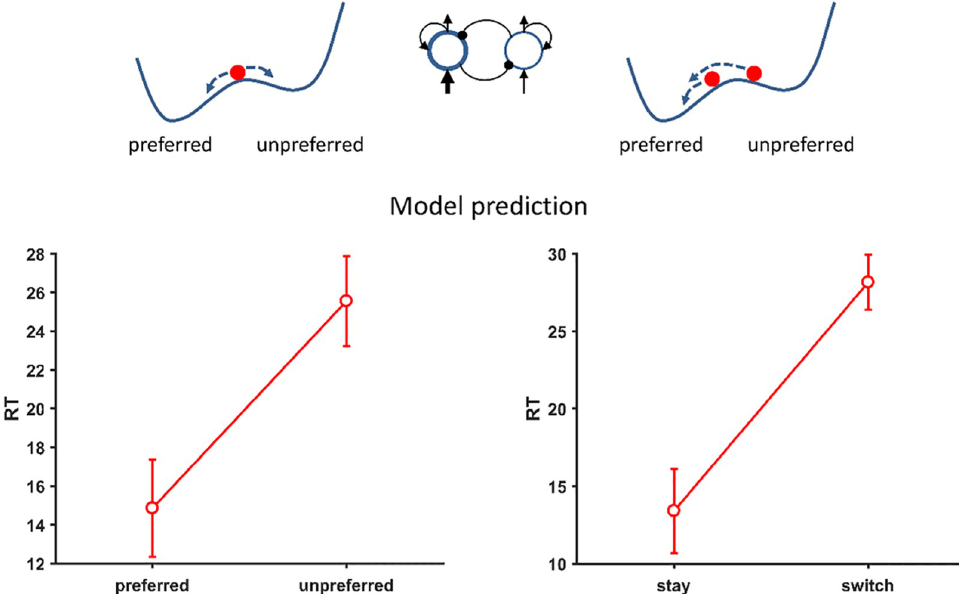
Fig 3. Model predictions for RT effects (in cycles) for specific trials in sequences of choices Left: When choosing between two options in trials with clearly given preferences (an attractive SN or attractive LN option), choosing the preferred option should be easier than choosing the unpreferred option. Right: In trials with clearly given preferences and choices of this preferred option, it should be easier to choose the preferred option repeatedly (staying with the preferred option) than to come from the unpreferred option (switching to the preferred